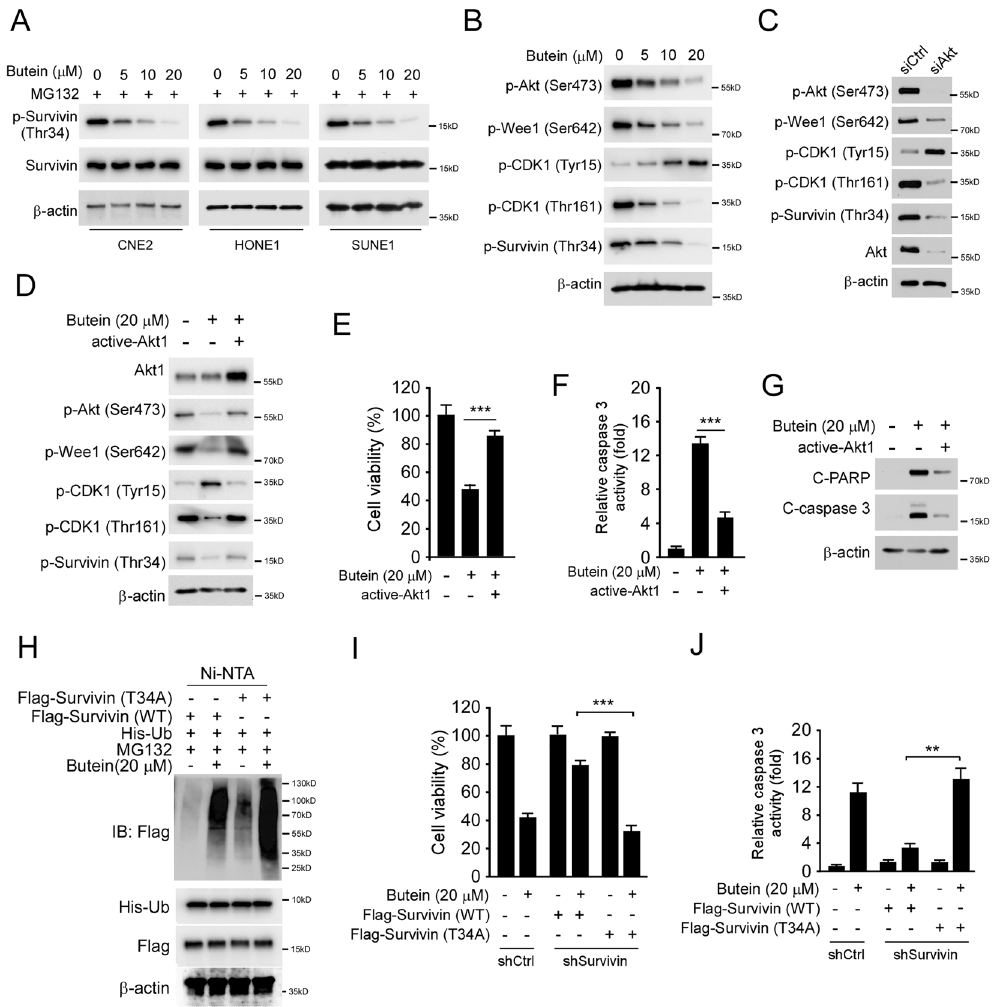
Figure 4. Butein suppressed Akt activity and reduced survivin Thr34 phosphorylation. ( A ) CNE2, SUNE1, and HONE1 cells were treated with Butein for 24 h, followed by MG132 treated for 8 h, and the WCE was